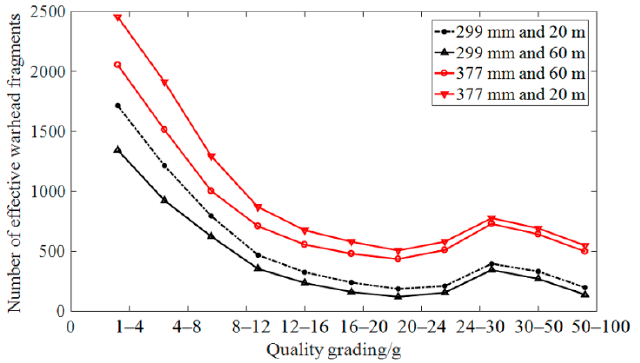
Figure 3. Warhead fragment quality distribution of the two types of warheads and the quantity distribution of the effective warhead fragments hitting the target. distribution of the effective warhead fragments hitting the